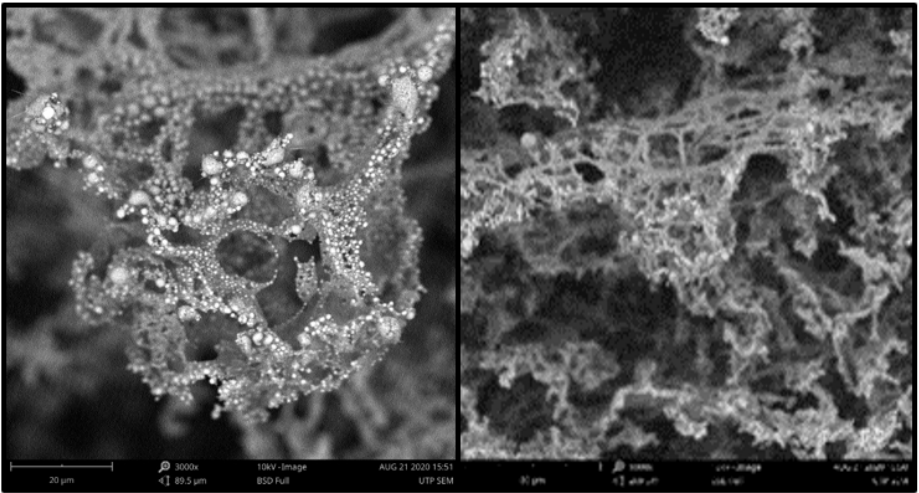
Fig. 4. SEM Imaging Microscopy of OP-LSG at (a), 20 µm resolution. (b), 80 µm